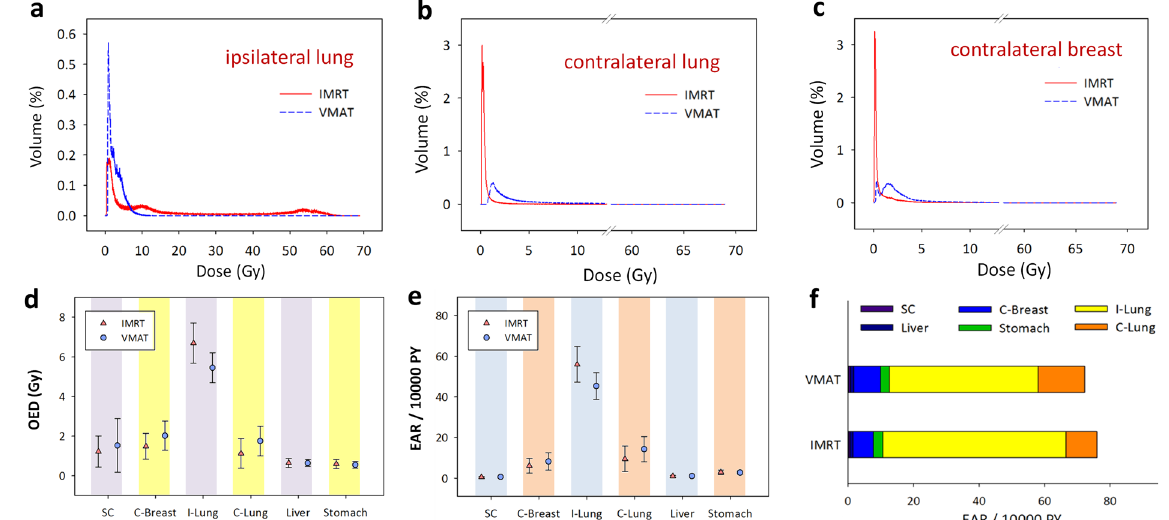
Figure 4. Differential dose volume histograms of the same two representative patients for irradiation of the ipsilateral and contralateral lung and contralateral breast for IMRT/VMAT breast radiotherapy ( a , b , c ). OED/ EAR of 30 patients (mean and standard deviation) using Schneider’s full model for 6 OARs for IMRT and VMAT ( d , e ). Accumulated EARs for 6 OARs at age of 70 years ( f ). The EAR has units of excess cases per 10,000 person-years (PY)/Gy. Abbreviations : IMRT, intensity-modulated radiotherapy; VMAT, volumetric-modulated arc therapy; OED, organ equivalent dose; EAR, excess absolute risks; SC, spinal cord; C-Breast, contralateral